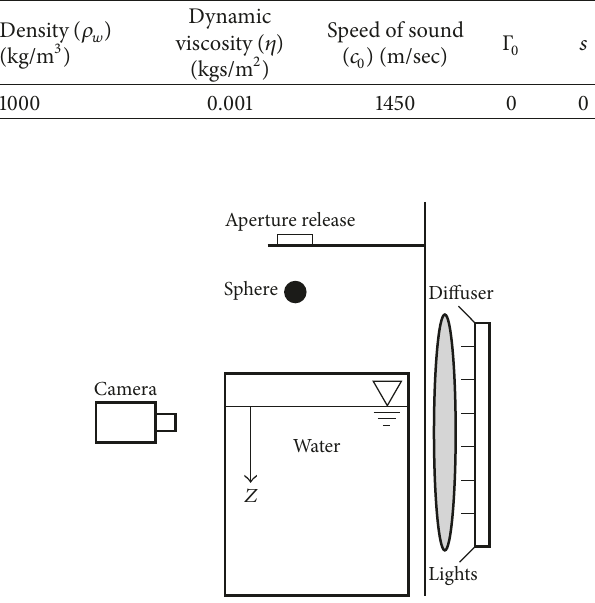
Figure 3: Schematic of the experimental apparatus of Aristoff et al.